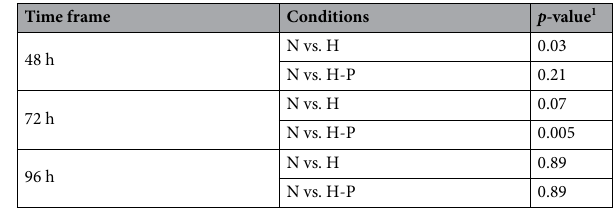
Table 2. Comparisons of mean of reduced Alamar Blue in different oxygen conditions at different time frames. N normoxia, H hypoxia, H-P hypoxia-physioxia. For details, see the “Methods” section. 1 Wilcoxon signed-rank